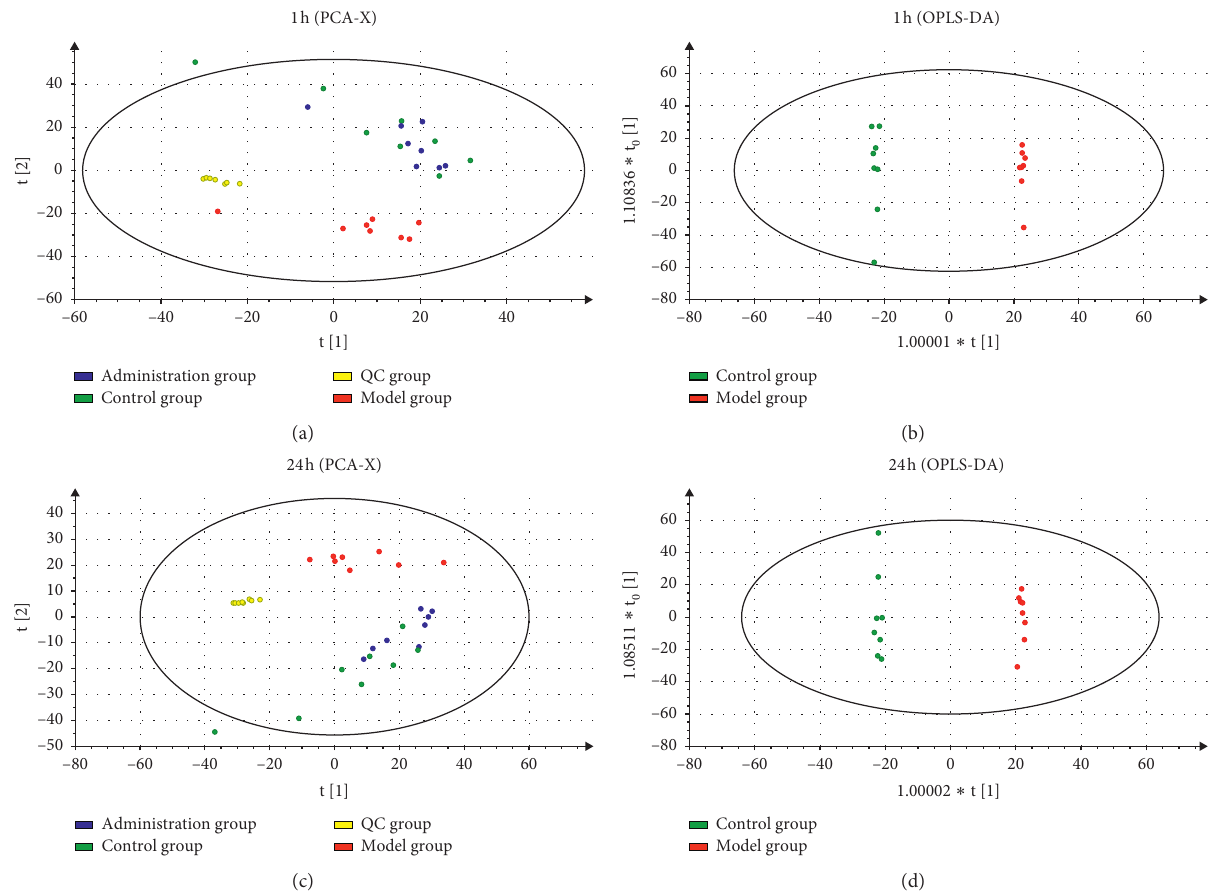
Figure 2: Overview of the sample: (a) PCA score plot in 1h after modeling; (b) OPLS-DA score plot in 1 h after modeling; (c) PCA score plot in 24 h after modeling; (d) OPLS-DA score plot in 24h after